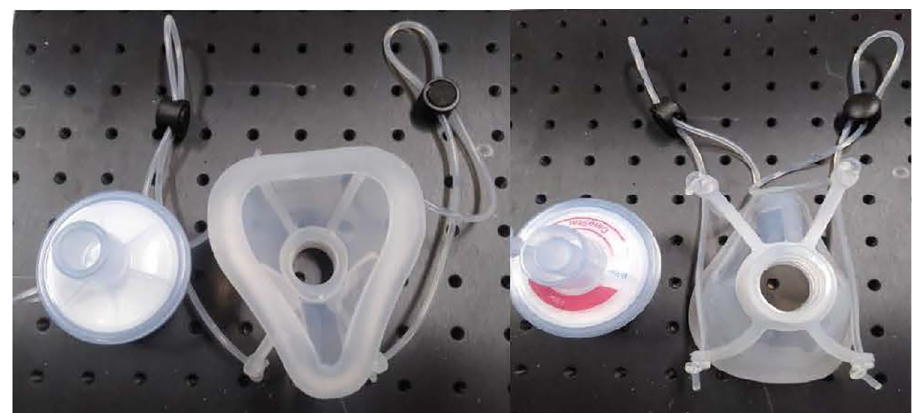
Fig 5. New silicone half-piece elastometric respirator.